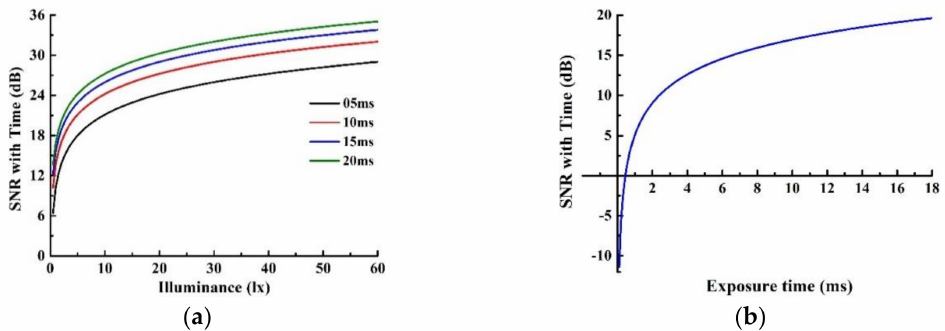
Figure 8. Curves of SNR versus ( a ) illuminance under di ff erent exposure times and ( b ) exposure times under certain illuminance.